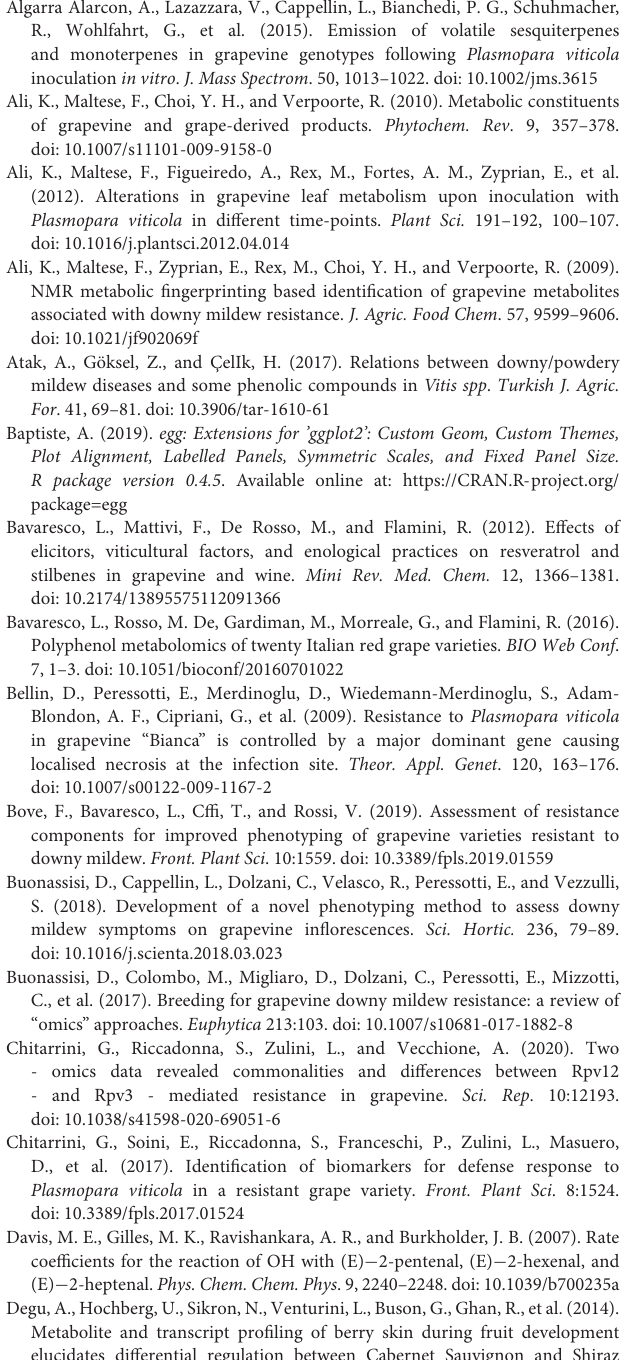
Stilbenes and Stilbenoids as Markers) (sheet 3) reported for each genotype and for each year. Supplementary Table 3 | The “d” values of the identified putative biomarkers for the mono-locus and pyramided